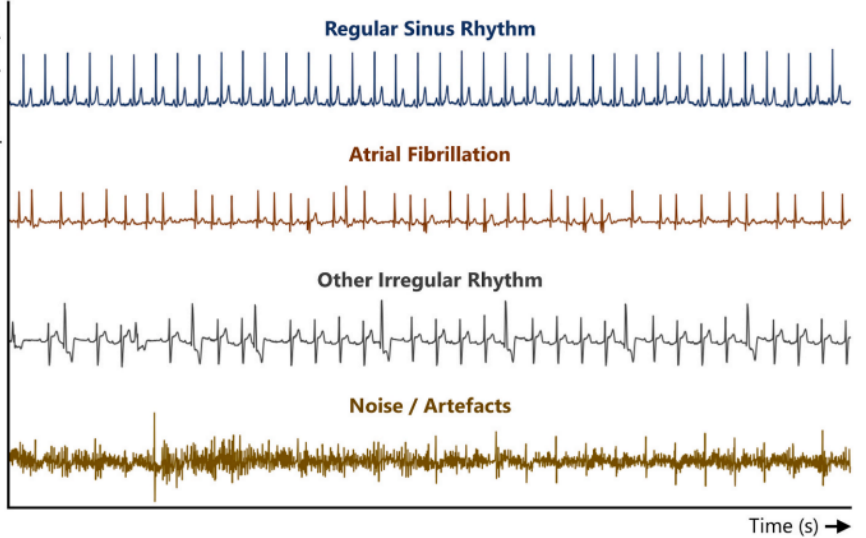
Figure 2. Typical ECG segments of the four different classes